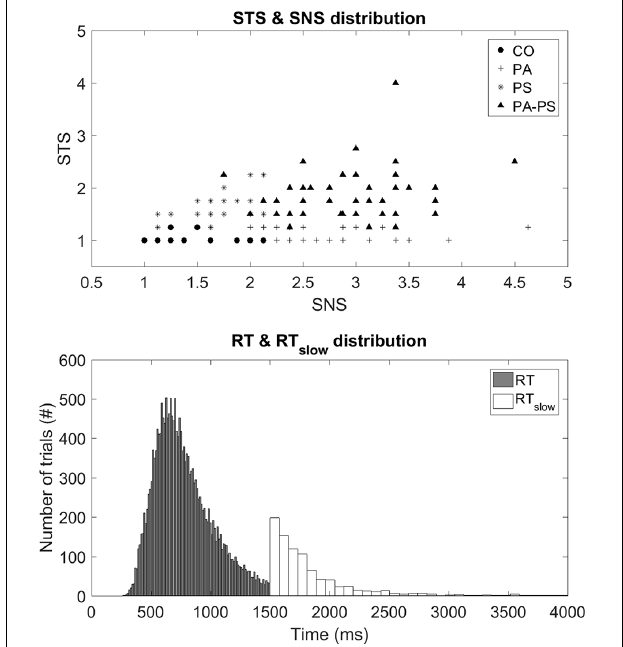
FIGURE 1 | (Top) STS and SNS distribution. Illustration of a scatter plot demonstrating the four groups with respect to the subscores STS and SNS on the vertical and horizontal axes, respectively. (Bottom) RT and RT slow distribution. Illustration of histogram demonstrating the distribution of the two behavioral parameters, RT and RT slow